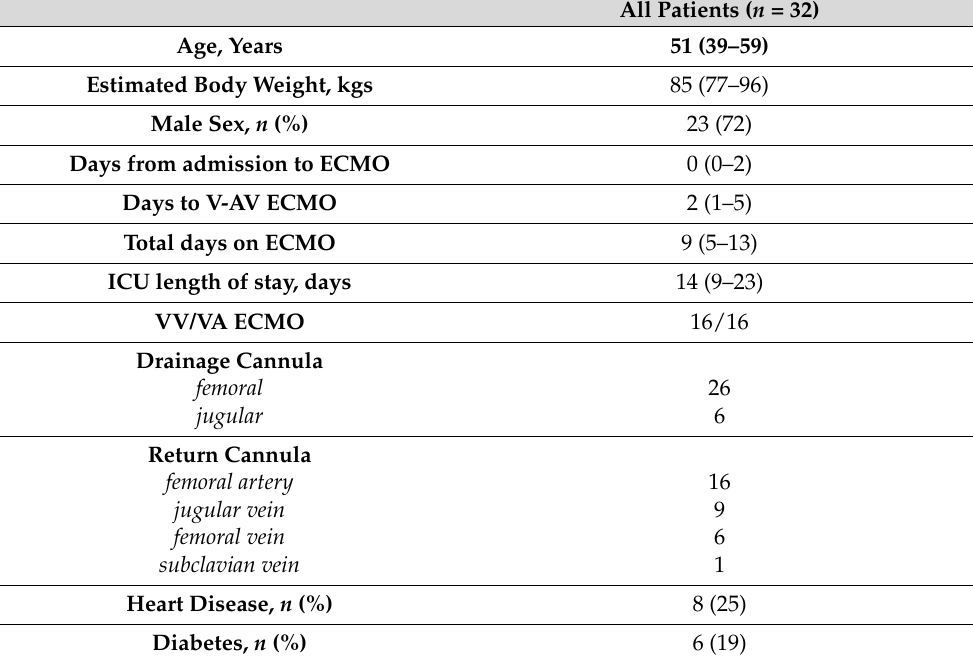
Table 1. Characteristics of the study population. Data are presented as count (percentage) or median (IQRs). BEFORE = initial ECMO support before conversion; AFTER = within 2 h from conversion to veno-arteriovenous (V-AV)